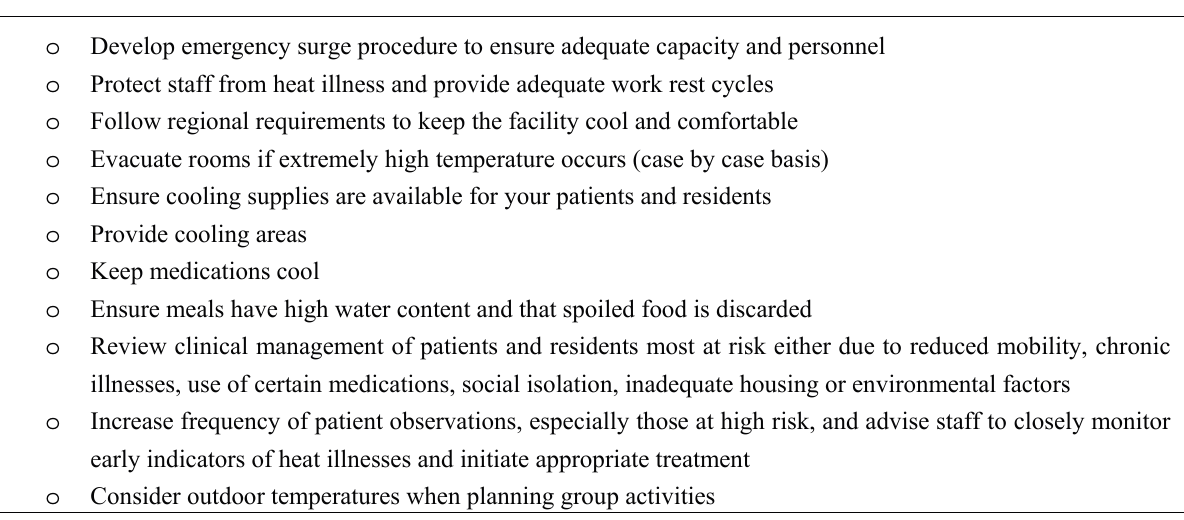
Table 3. Health care facility protocol for ensuring the health and safety of patients during extreme heat